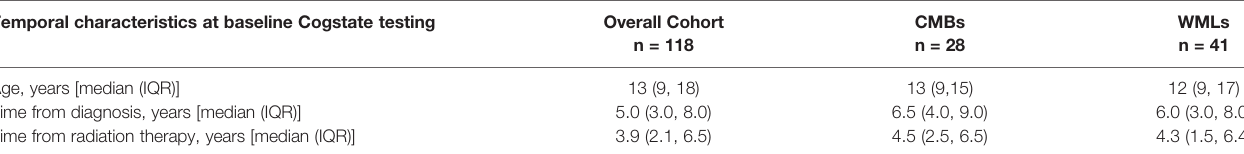
Table describes age at time of Cogstate neurocognitive testing, time from diagnosis to testing, and time from radiation to testing. IQR, interquartile range; CMBs, cerebral microbleeds; WMLs, white matter